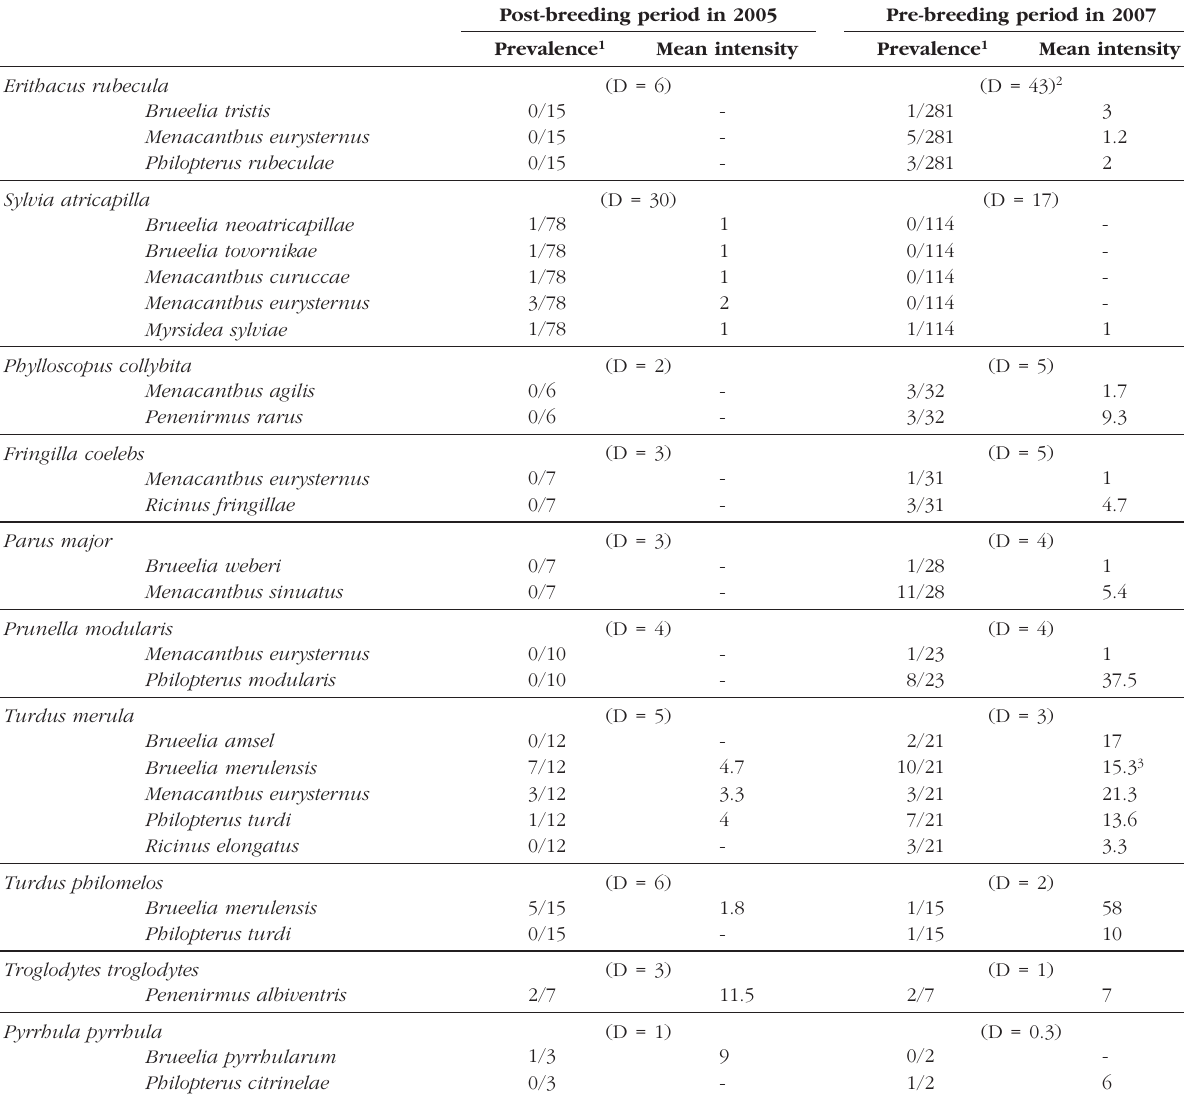
Table III. – Comparison of chewing lice found on birds of individual species in pre-breeding and post-breeding